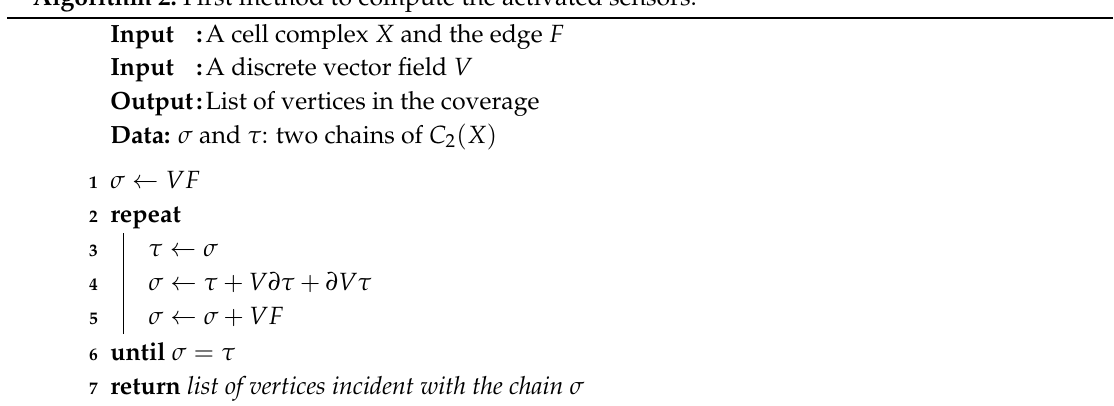
Algorithm 2: First method to compute the activated sensors.